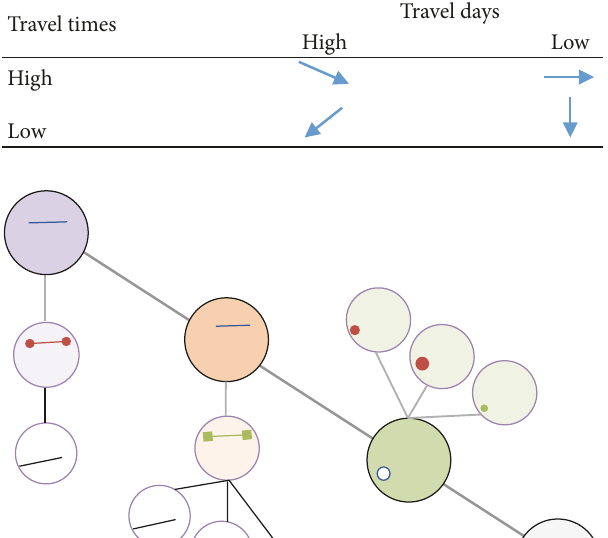
travel space position (big circle) is set as the first layer of the travel behavior graph, and travel time (median circle) and route (small circle) are treated as the second and third layers. Every layer is considered as a node of travel association map. In each layer, the horizontal and vertical coordinates are uniformed as well as the symbols and lines. After further